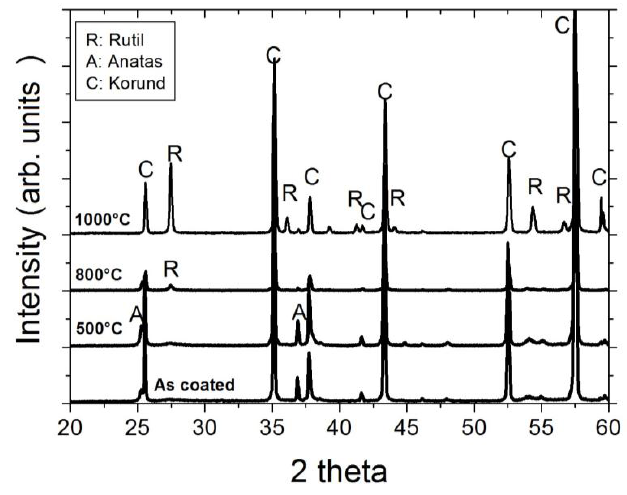
Figure 2. Top-view SEM micrographs of the sputter-coated Al-doped TiO 2 layer in the as-coated case ( left ), and after heat-treatment at 800 °C for 3 h in air ( right ).